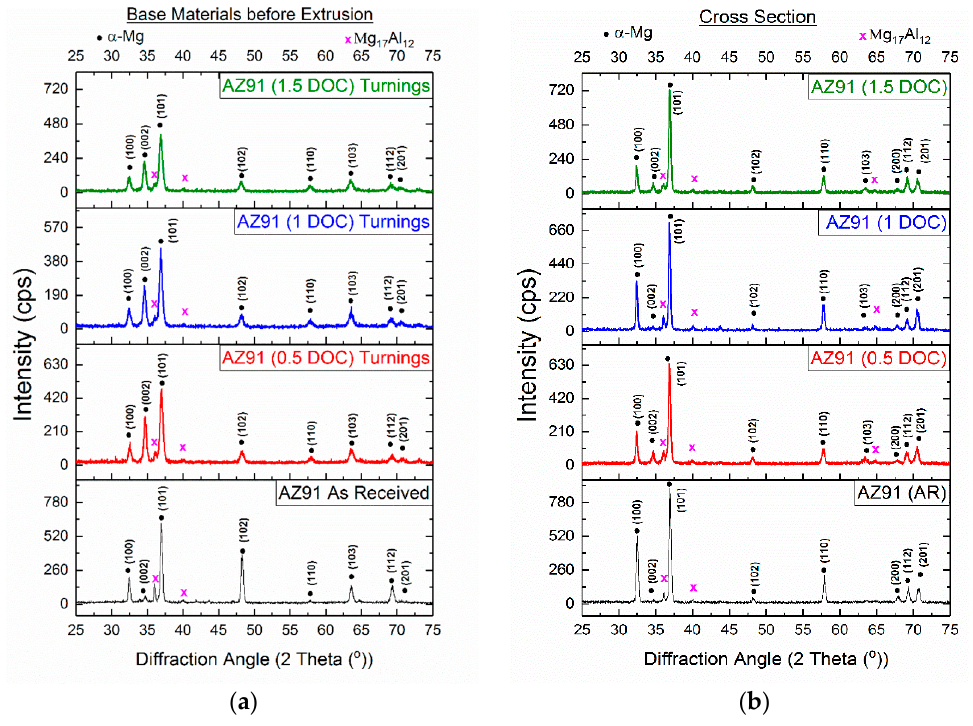
Figure 4. XRD of ( a ) base materials i.e., turnings/chips before extrusion, and ( b ) extruded materials.